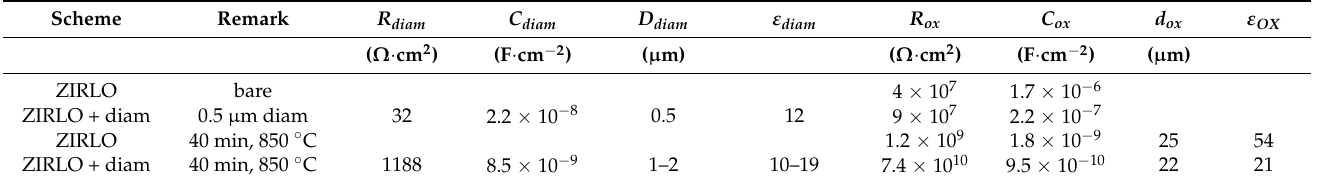
Table 2. Impedance parameters estimated by approximating experimental data with the impedance of the equivalent circuits in Figure 5; diamond coating and oxide thicknesses and effective dielectric constants as estimated from relation (3).